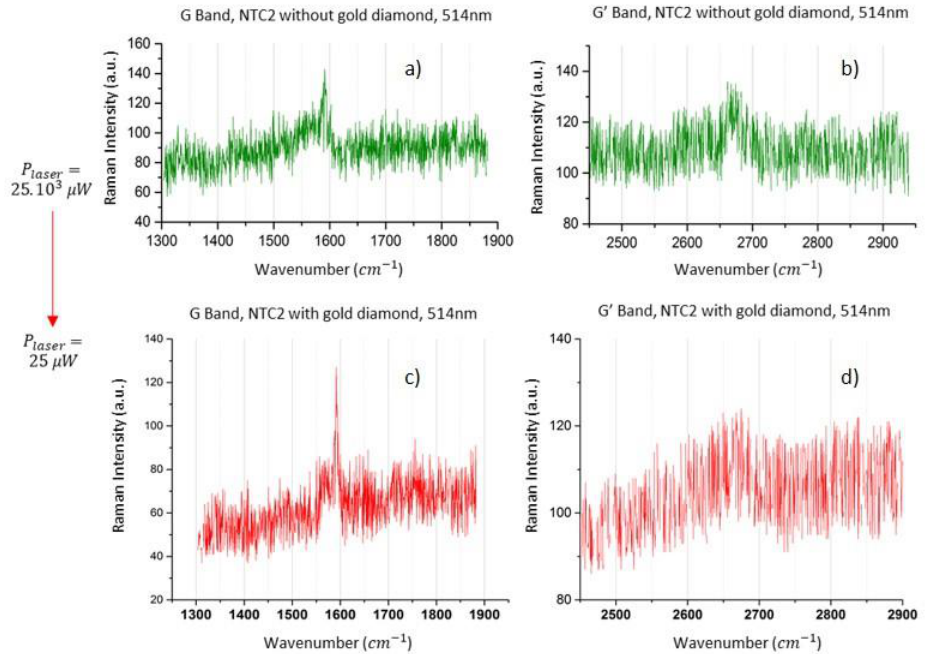
Figure 5. Spectra obtained (6 accumulations of 10 s) at the limit of detections, for the CNT 2 tube of the Figure 3; ( a , b ) G and G’ bands of CNT 2 without gold excited at 514.53 nm, for a significant focused power of 25 mW, on around 1 µm 2 ; ( c , d ) the Raman signals at the detection threshold of CNT 2 dressed with two gold particles on each side, recorded with an incident laser power of 25 µW, i.e., 1000 times lower than in the previous conditions.